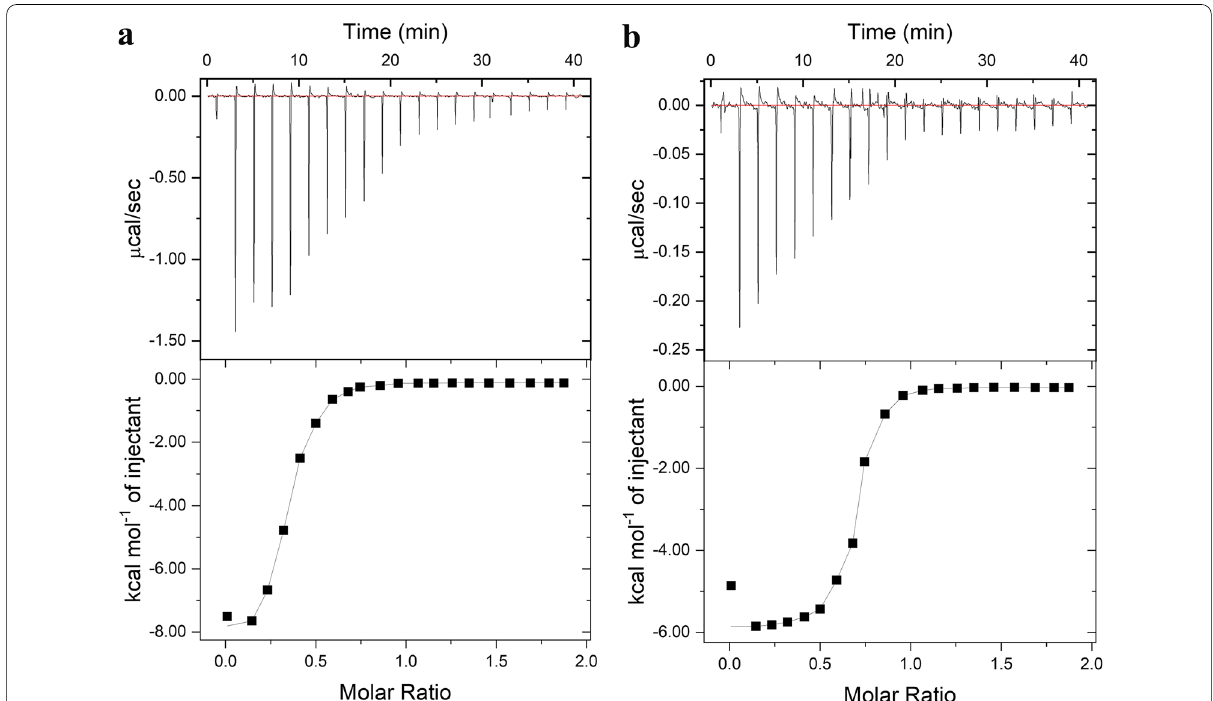
Fig. 4 The affinity measurements between DmFdx2 and PRF/KshA by ITC. The affinity of reductase PRF ( a ) and oxygenase KshA ( b ) (0.2 mM titration and the curve fit of the observed heat are displayed in the upper and lower panels, respectively